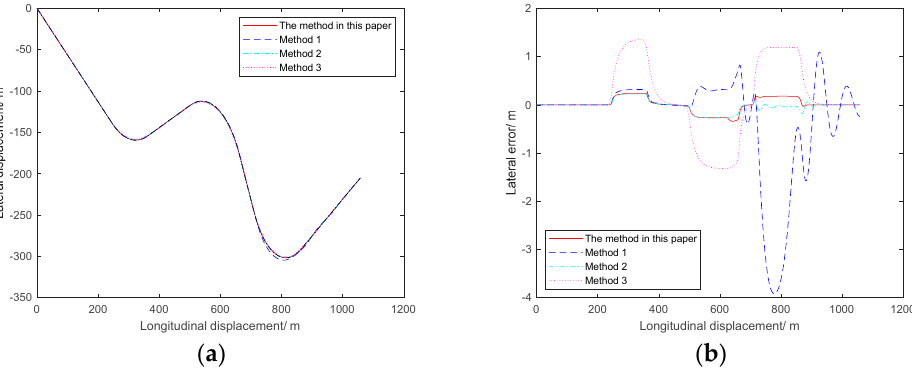
Figure 9. Simulation results of variable speed on the Alt 3 road: ( a ) Variable ‐ speed path ‐ tracking effect. ( b ) Variable ‐ speed lateral tracking error.